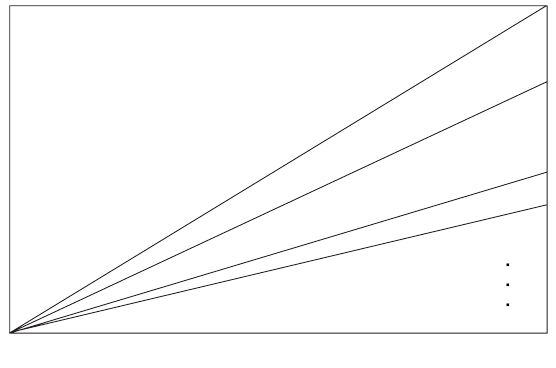
Figure 1 . A tiling in R